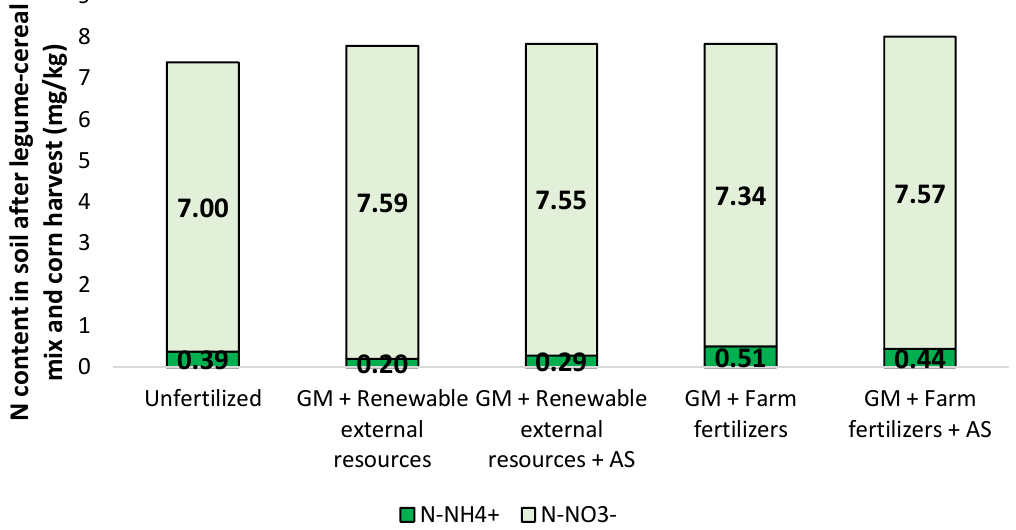
Figure 7. Average yield of legume-cereal mix and silage corn recalculated to the cereal units per hectare (observed treatments, 2018). Error bars represent the standard error (SE). Different letters mean statistical difference ( p ≤ 0.5).